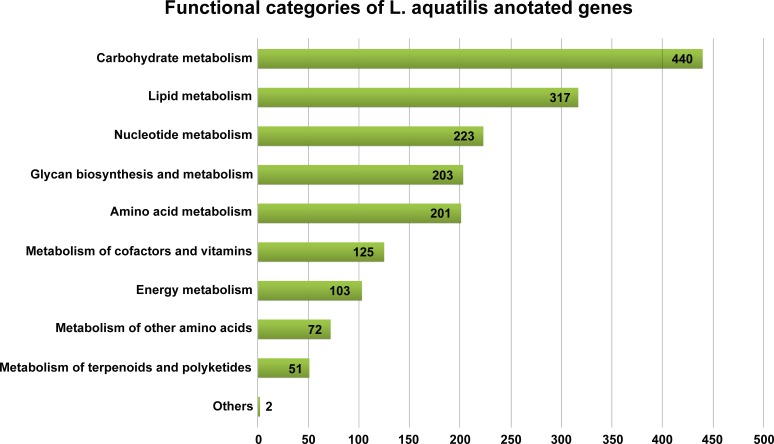
Metabolism functional categories of L. aquatilis annotated genes.The genes categorized in the metabolism category were further categorized into ten subcategories with the majority in the carbohydrate metabolism.